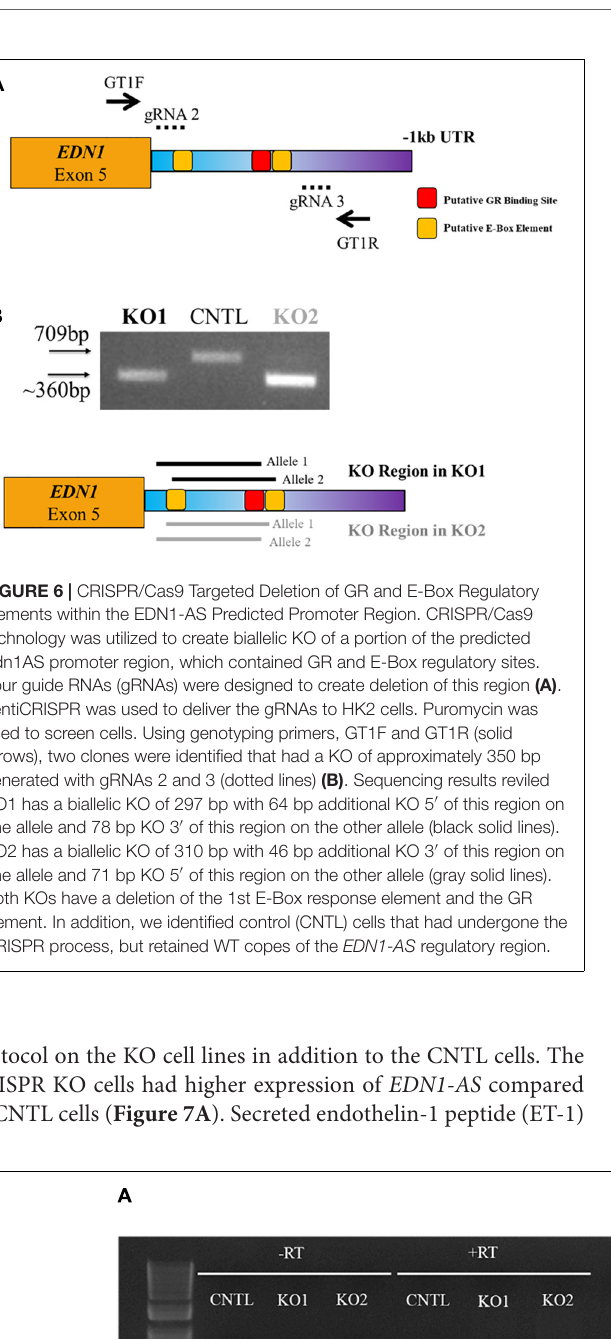
FIGURE 7 | CRISPR/Cas9 KO of EDN1-AS Regulatory Elements Results in Increased EDN1-AS and EDN1 Expression. EDN1-AS expression levels were examined in CNTL and CRISPR/Cas9 KO cells by strand-specific RT PCR. For each reaction, 20 ng of cDNA was used in PCR reactions to amplify EDN1-AS . CRISPR/Cas9 KO cells had more EDN1-AS expression visualized by gel electrophoresis (A) (gel representative of n = 3 for CNTL and n = 2 for each KO cell line). To determine if these differences in EDN1-AS expression had an effect on EDN1 expression, the product of the EDN1 gene, endothelin-1 (ET-1) peptide was measured. Cells were placed in Transwells dishes and grown to confluence. Media from these cells was used in an endothelin-1 ELISA (R&D QuantiGlo ET-1 ELISA) to determine the amount of secreted ET-1 relativized to total protein concentration (B) . One-way ANOVA was used to determine significant differences between each KO and the CNTL cell line, n = 7 for each cell line. * P <